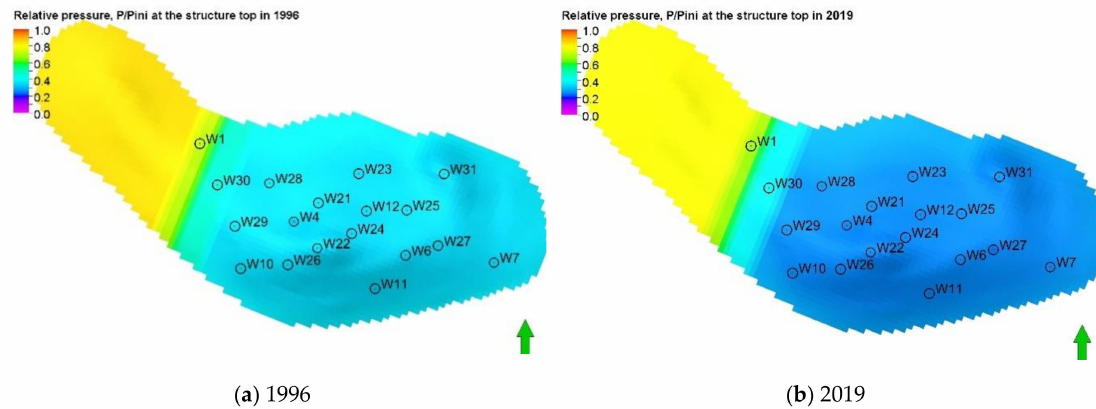
Figure 24. Relative pressure distribution at the structure top.